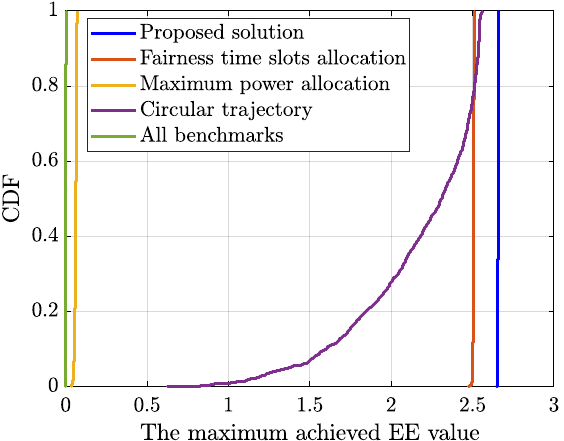
Figure 5. The CDF of the maximum achieved EE value (bit/joule) when N = 5, L =